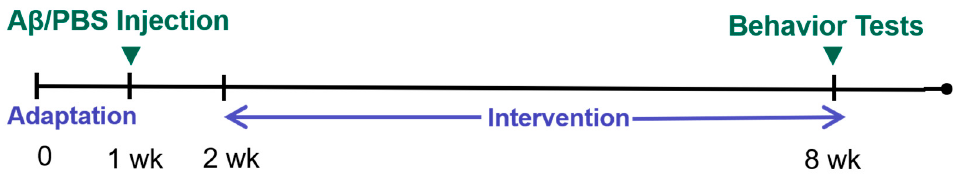
Figure 1. The experimental procedure timeline. Note: wk = week, PBS = phosphate-buffered saline. Table 2. The treatment of mice in different groups.